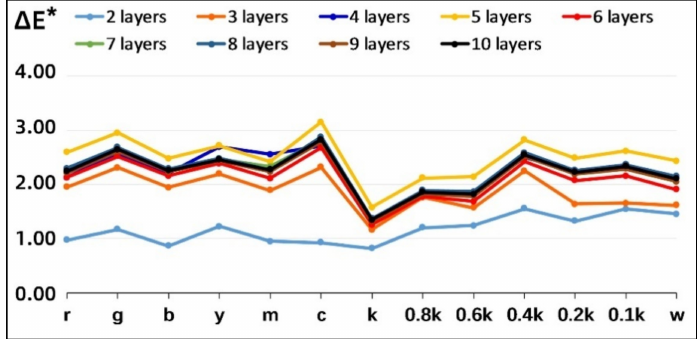
Figure 3. Average color difference of nine controlled combinations.